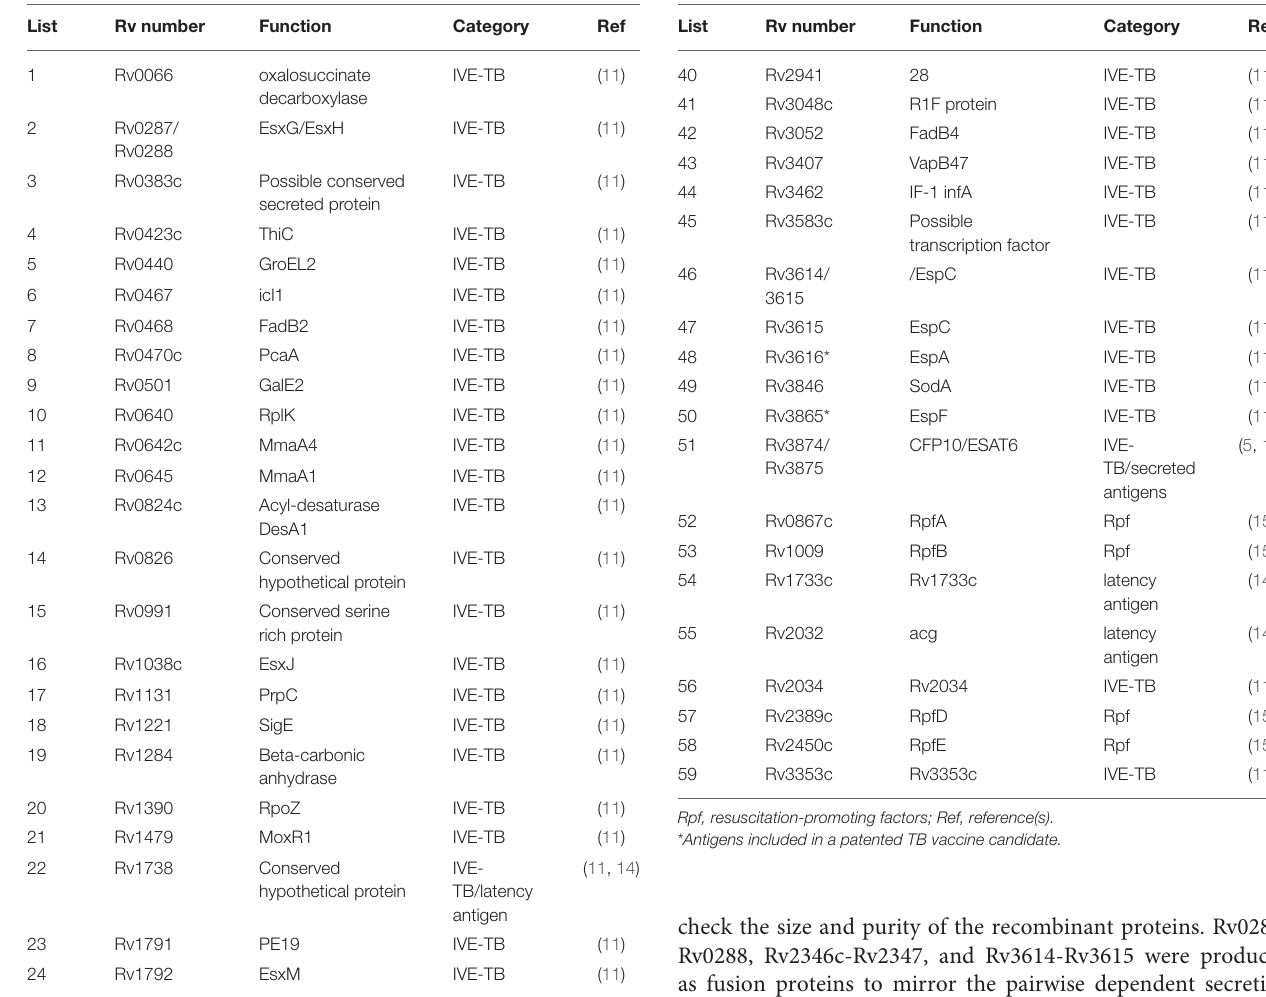
TABLE 2 | List of Mtb antigens included in this